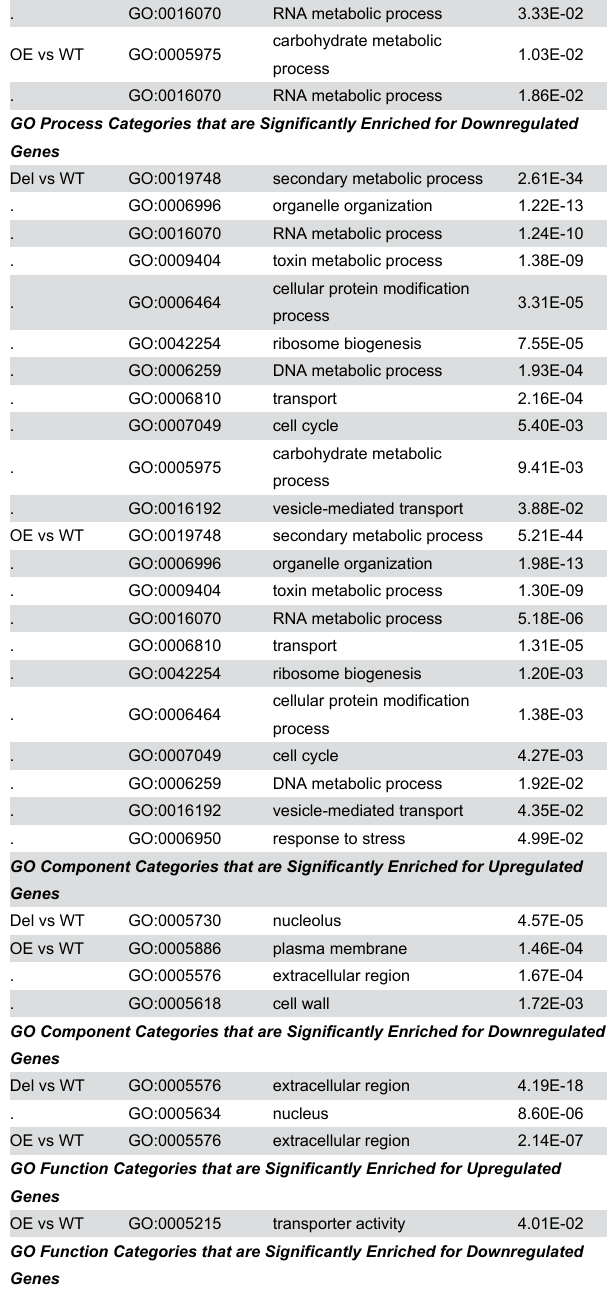
(Afu8g00420) (Figures 2 and 3), a gene encoding a putative C6 type transcription factor that our previous bioinformatics analysis identified within the fumagillin gene cluster, located in chromosome 8 [53]. We further validated these results by qRT- PCR analysis (Figure S1). The expression levels of fumR